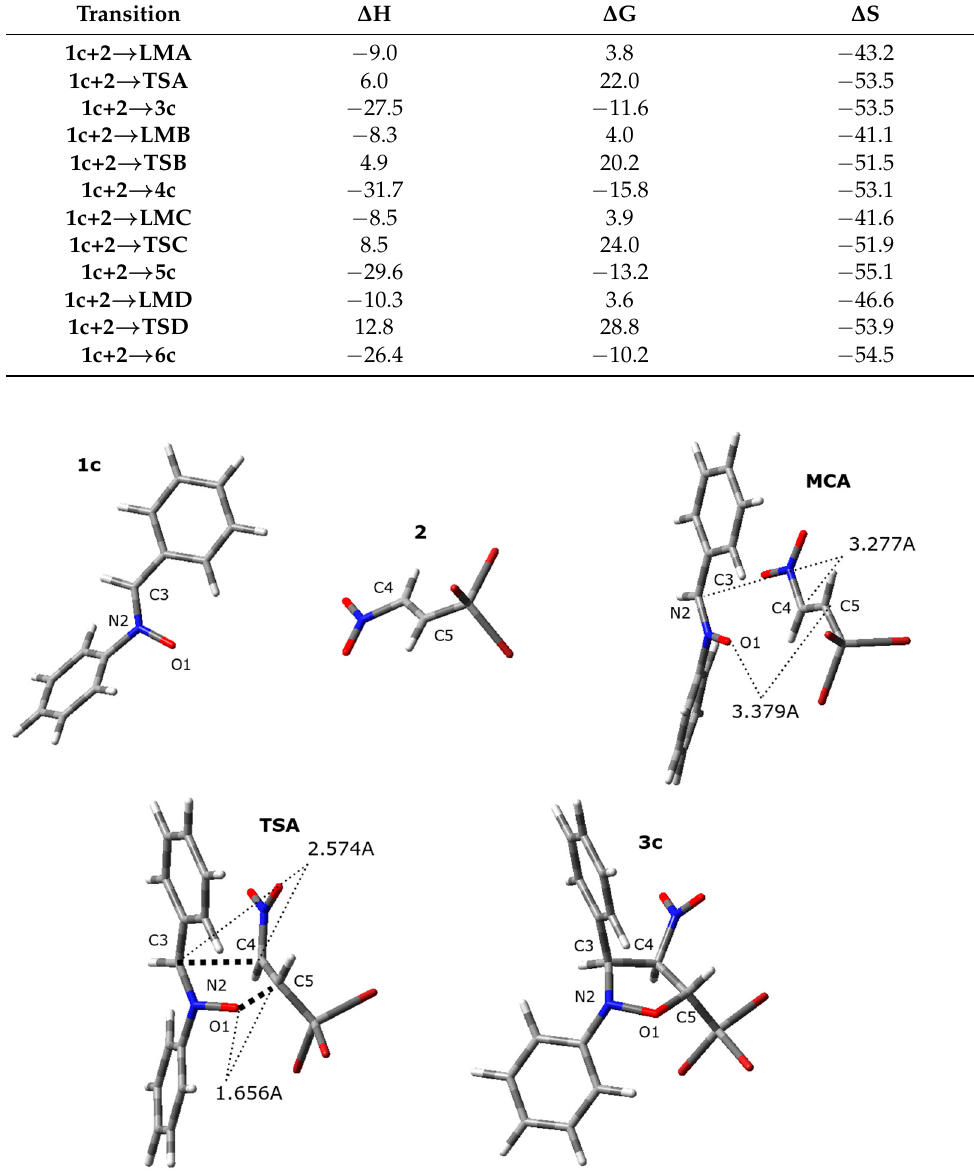
Table 3. Energetical parameters for reaction 1c+2 in light of the wb97xd/6-311+G(d) (PCM) calculations.